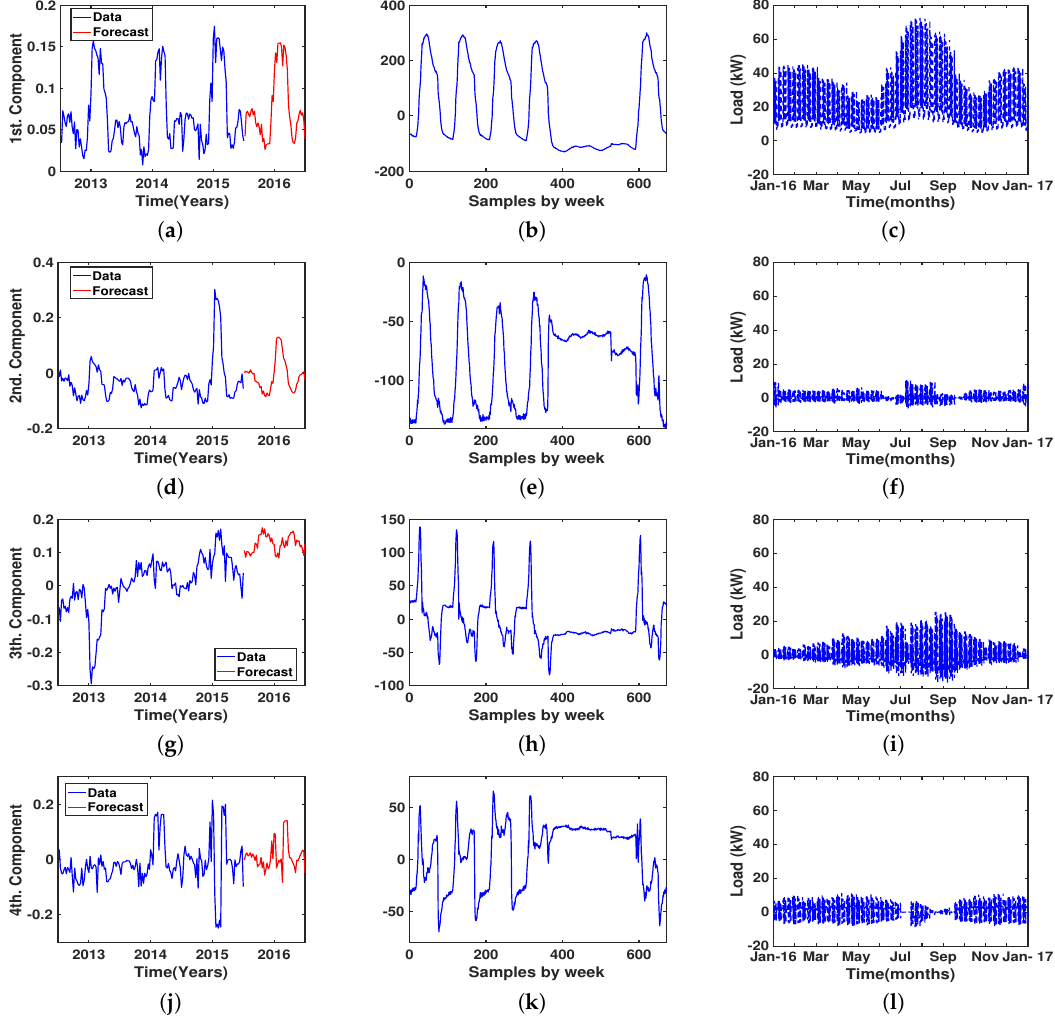
Figure 6. Principal component analysis (PCA) load prediction for Centro de Especialidades El Arroyo (CEA). For the first, second, third, and fourth components, panels show the projection of the coefficients over the year ( a , d , g , j ), the eigenvector corresponding to that component ( b , e , h , k ), and the yearly reconstructed partial load with that component ( c , f , i , l